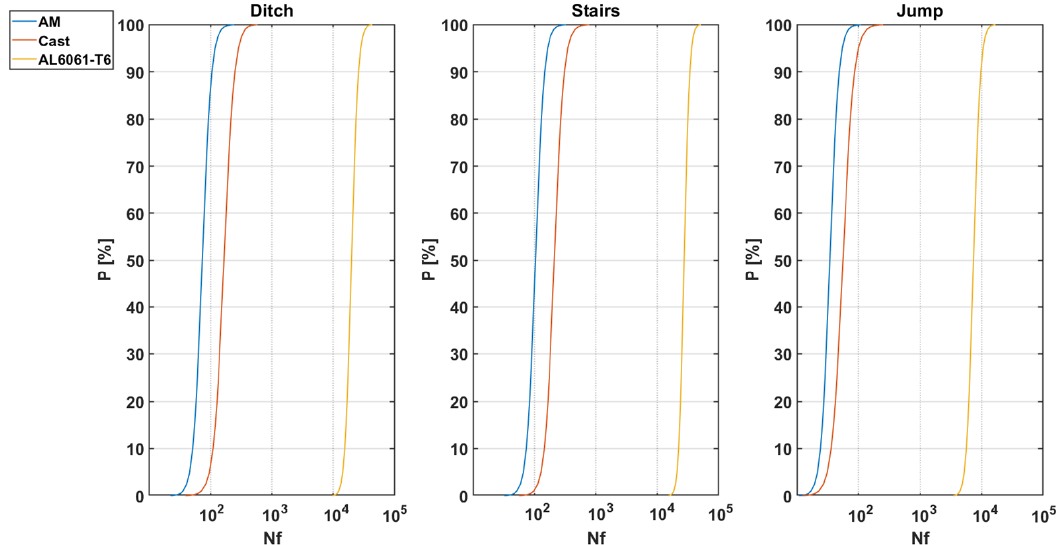
Figure 11. Fatigue lifetime distribution function for each obstacle. Table 6. Number of obstacle repetitions to failure corresponding to 50% probability of occurrence. Mat.